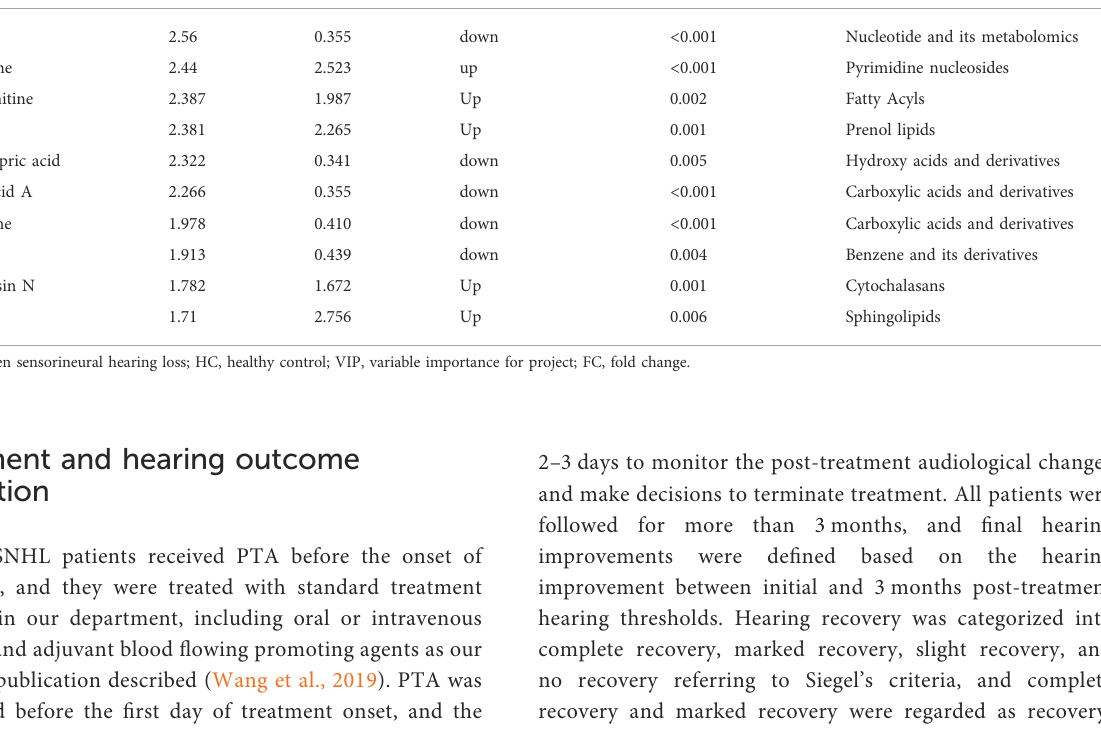
TABLE 2 Top ten distinctive metabolites between SSNHL patients and HCs.